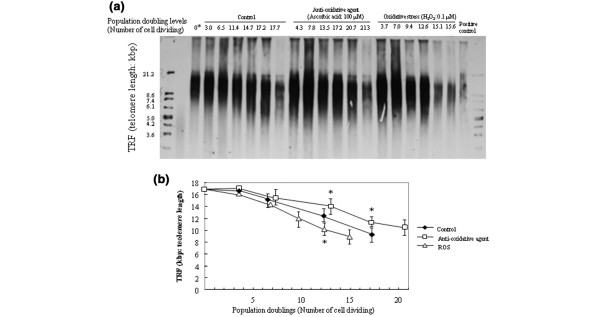
Southern blot analysis of chondrocyte telomere lengths in cultured chondrocytes at each passage under the different oxidative conditions. (a) Representative image of Southern blot analysis. Telomere lengths in chondrocytes (1 × 106 cells/dish, initial subculture at the start of the experiment: chondrocytes at passage 3 or 4) were determined using the terminal restriction fragment (TRF) assay. (b) The mean lengths of the chondrocytes were calculated by densitometric molecular weight analysis and were plotted against the number of cell population doublings. *P < 0.05, versus control group at each incubation time. ROS, reactive oxygen species.